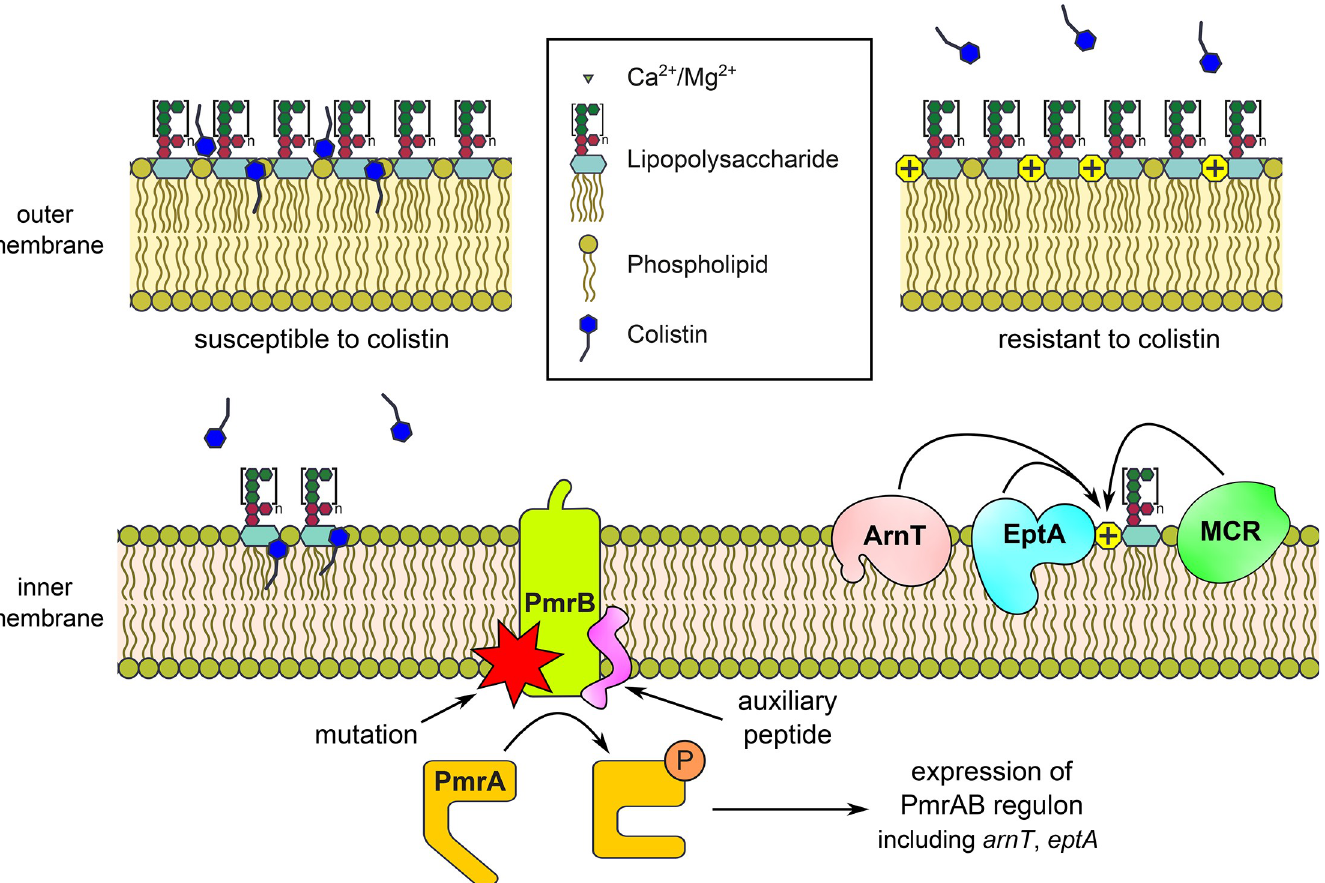
Fig 1. Colistin susceptibility and resistance in E . coli . Colistin initially targets LPS in the outer membrane of E . coli through electrostatic interactions with negatively charged phosphate groups on the lipid A moiety of LPS. After destabilizing the outer membrane, colistin binds to LPS molecules that are located in the outer leaflet of the cytoplasmic membrane while they await transport to the outer membrane. The resulting disruption of the inner membrane is proposed as the main cause of cell death. Previous studies in E . coli have revealed that mutations in the sensor histidine kinase PmrB are an important mechanism of colistin resistance, leading to the constitutive production of the enzymes ArnT and EptA that add a positive charge (4-amino-4-deoxy-L-arabinose and phosphoethanolamine, respectively) to the phosphate groups of lipid A, thereby reducing the affinity of colistin to lipid A. An alternative pathway toward colistin resistance is provided by acquisition of mobile genetic elements that carry mcr genes which also leads to the decoration of lipid A with phosphoethanolamine. Knopp and colleagues [12] show that novel auxiliary peptides can also cause colistin resistance through direct interactions with PmrB, leading to the activation of the two-component system. LPS, lipopolysaccharide; mcr , mobilized colistin